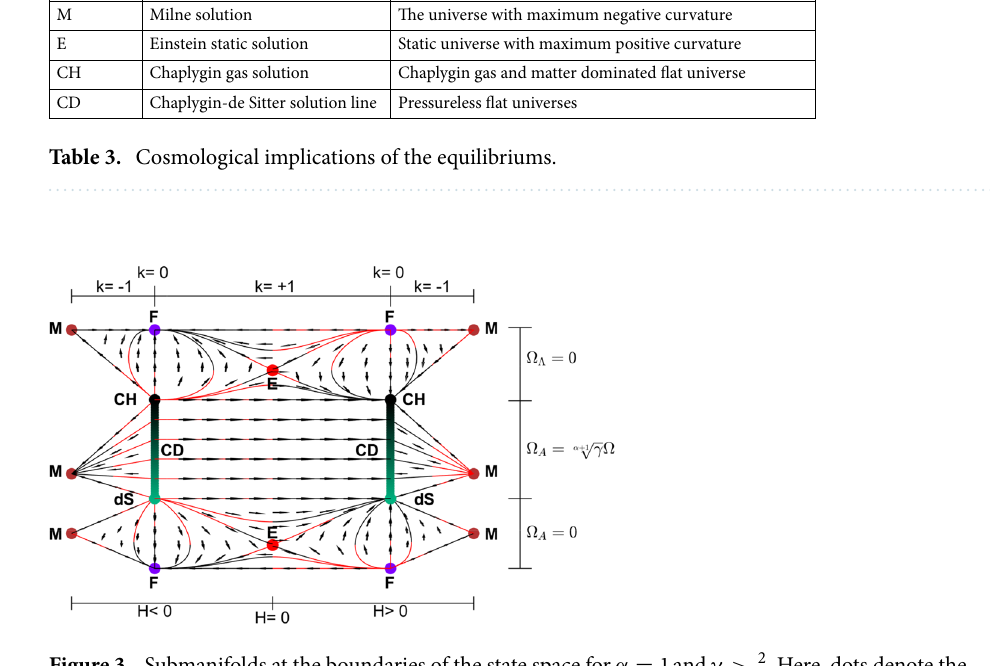
Figure 3. Submanifolds at the boundaries of the state space for α solutions of the system; F, M, dS, E, CH and CD represent Flat FL solution (� Milne solution (� static solution ( H Sitter solution line